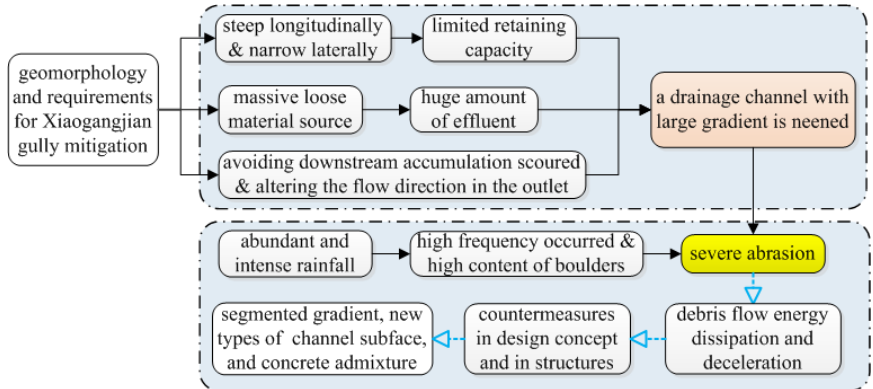
Figure 2. Analysis of design needs for drainage channel of Xiaogangjian debris flow. (The continuous arrows indicate that a drainage channel with a large gradient (DCLG) is needed for the mitigation and it will encounter abrasion, and the dashed arrows show the countermeasures for reducing the abrasion; the two blocks with different colors indicate key nodes in the design.).